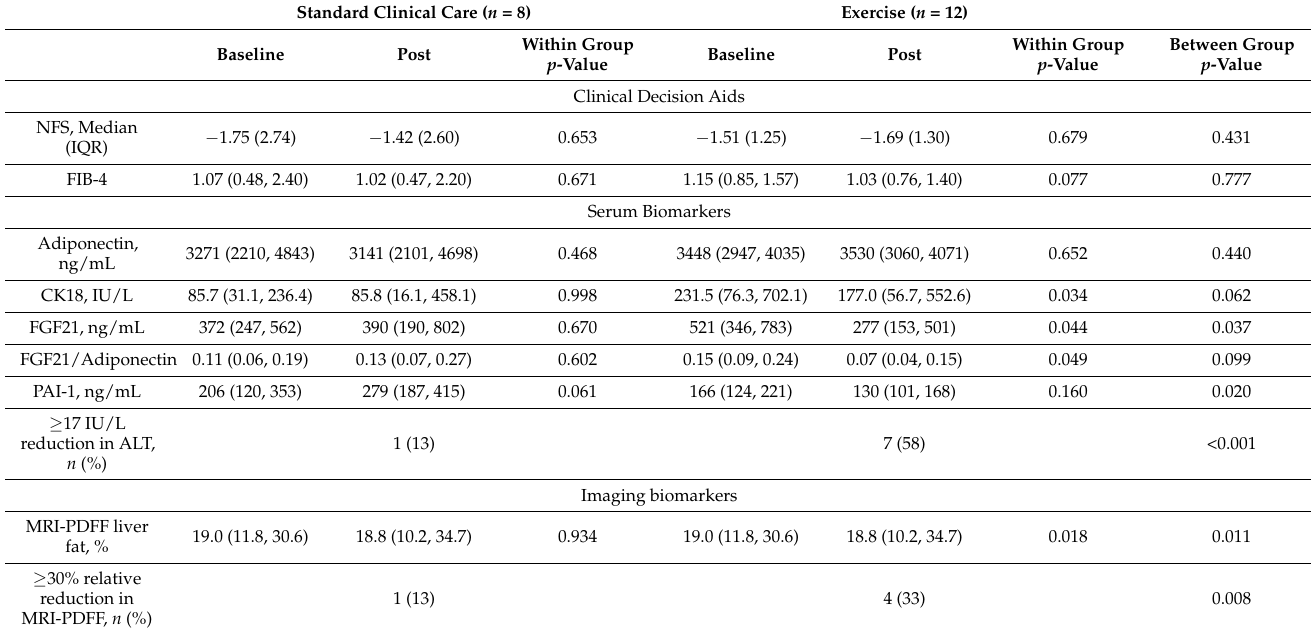
Table 2. Outcome measures: Non-invasive tests.